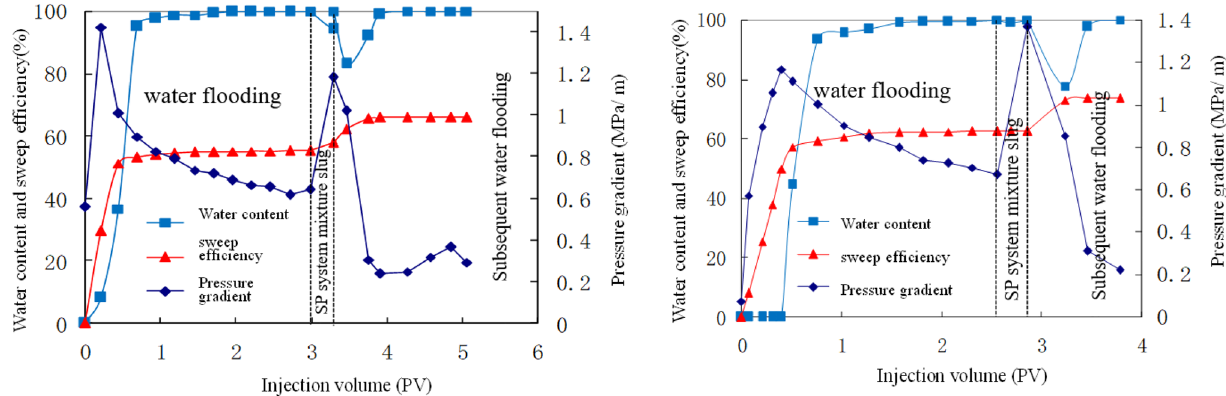
Fig. 13 Core flooding experiment results Polymer-surfactant mixture AN125VM + KD-2(left) and AN125VM + AEO(right)